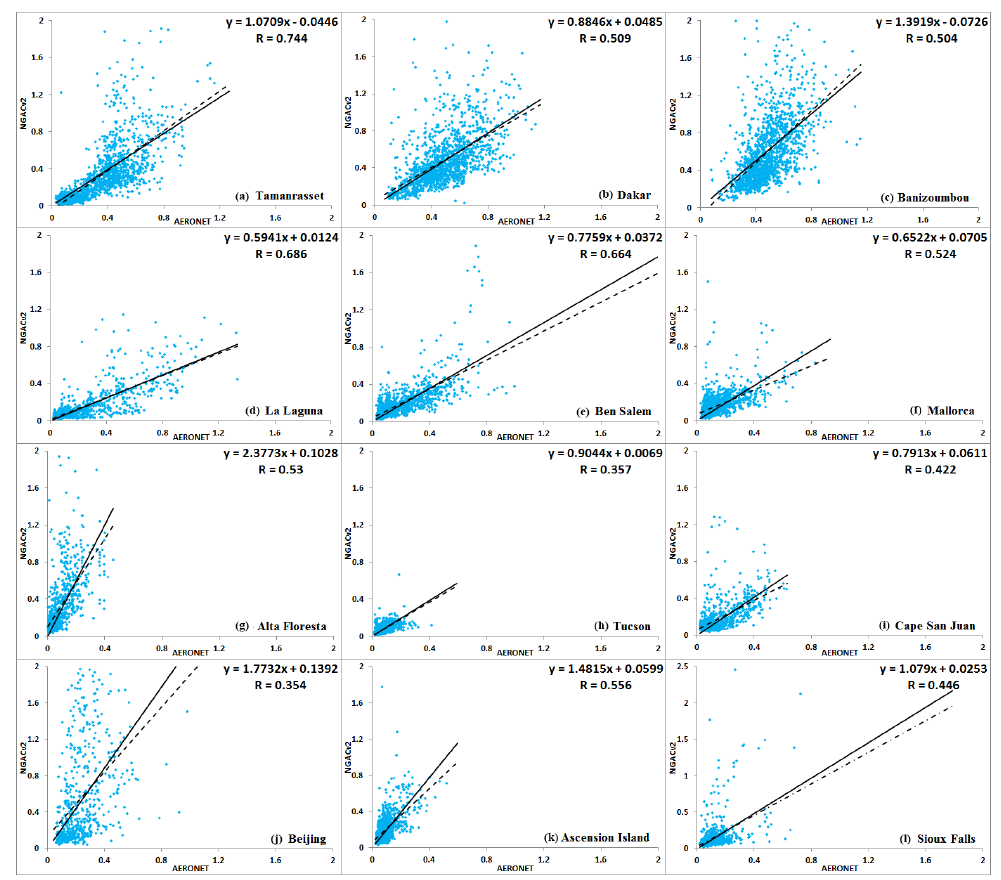
Figure 7. Correlation plots of 550nm AOT between NGACv2 and 12 AERONET locations. Black continuous lines in the panels represent the 1 : 1 line, while dotted black lines represent linear regression fits to data points. Actual locations of AERONET centers are listed